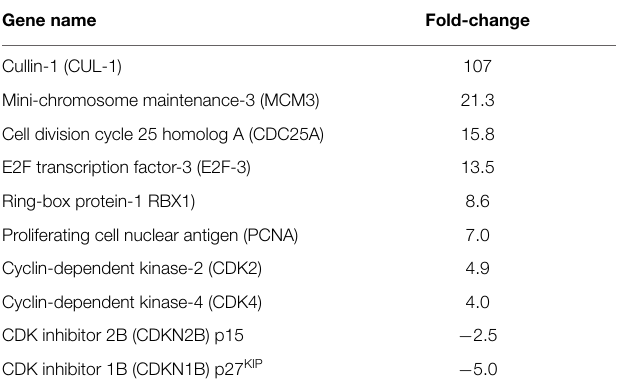
TABLE 1 | Cell proliferation genes activated by over-expressed